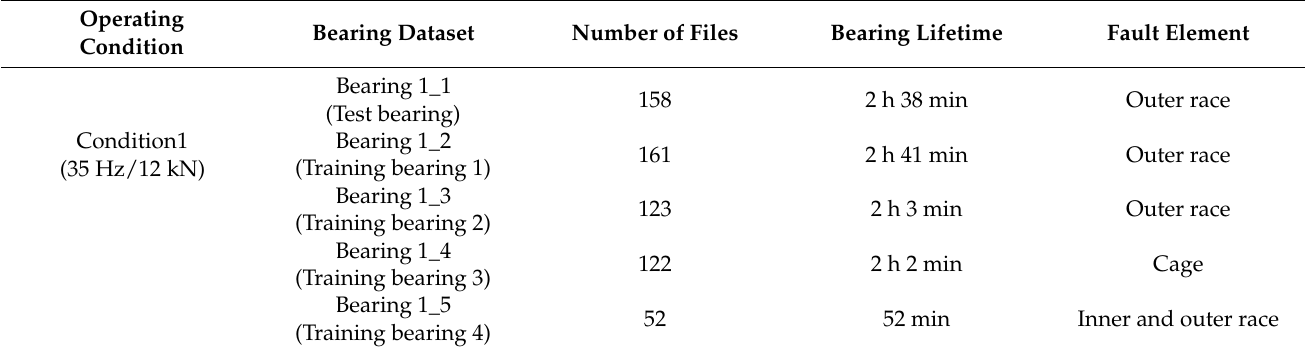
Table 2. Bearing